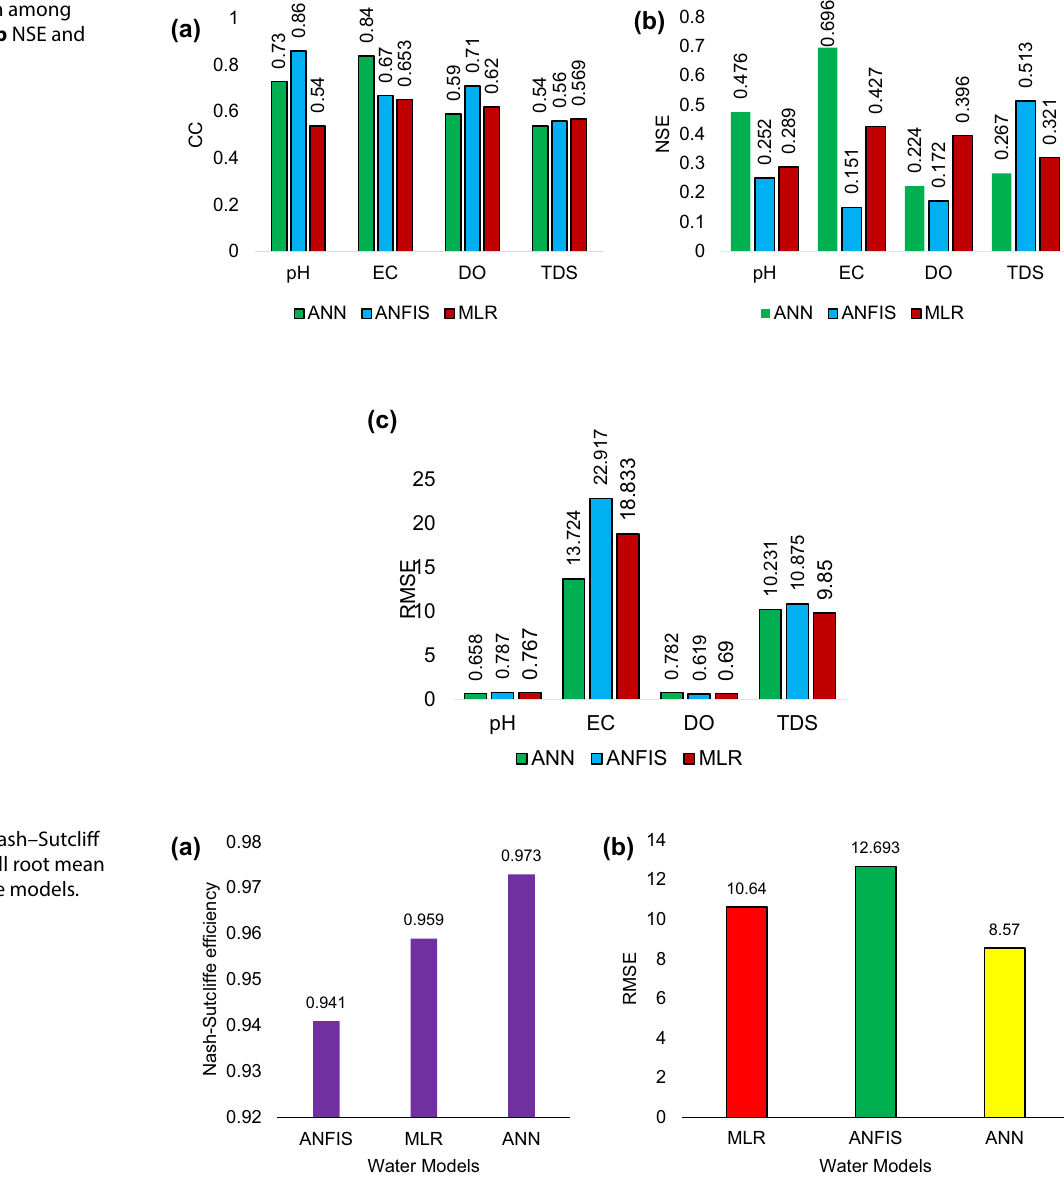
Fig. 8 Comparison among the models: a CC, b NSE and c RMSE